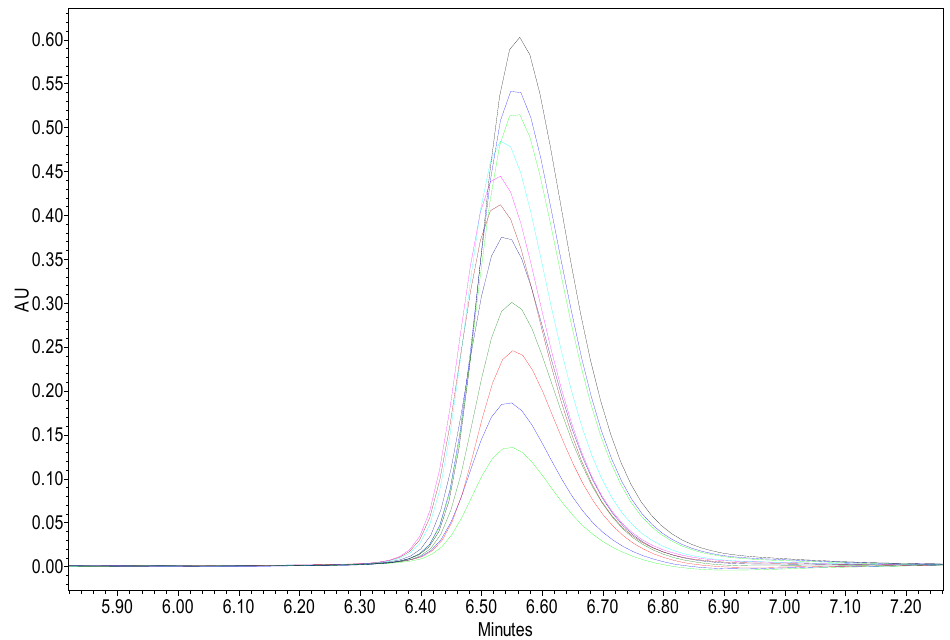
Figure 13. High performance liquid chromatography (HPLC) chromatograms collected during a photocatalytic experiment showing degradation efficiency of CA in the presence of Zn3La400 under UV-A irradiation as well as the formation of reaction intermediates and = 500 mg/L ; [CA] = 50 mg/L.